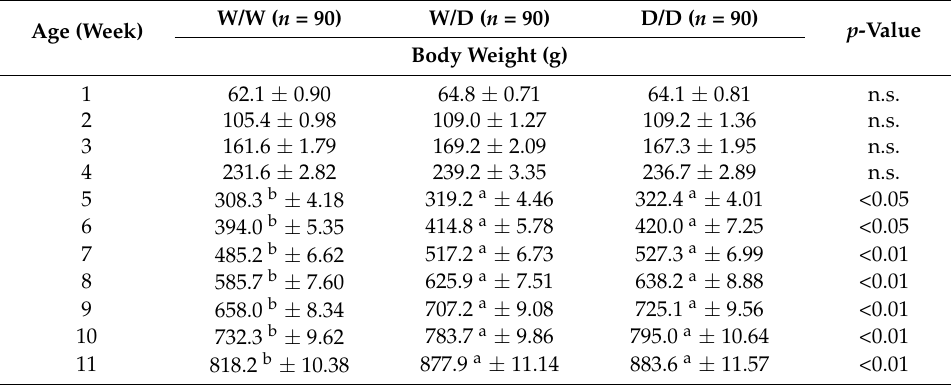
Table 1. Body weight development of hens of different genotypes (mean ±